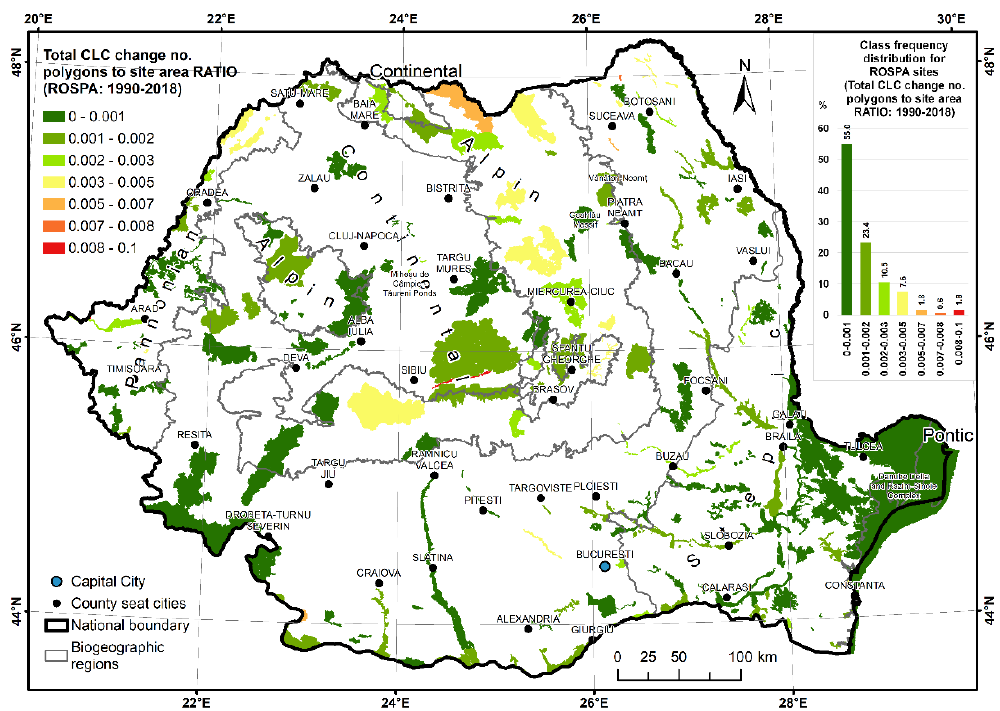
Figure 4. Changed polygons number to site area ratio for ROSPA (1990–2018).